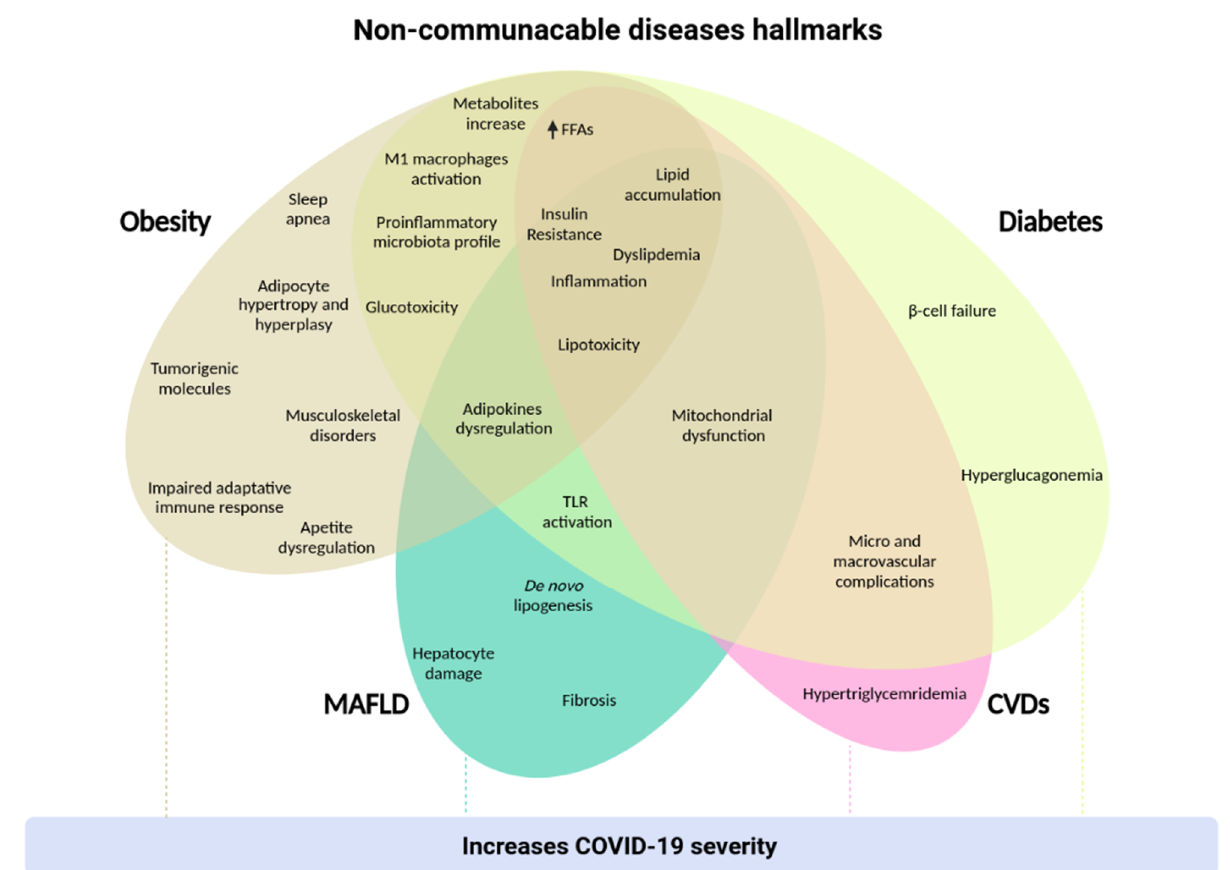
Figure 1. Hallmarks of non-communicable diseases. Scheme with the main characteristics and complications of the NCDs represented in 5-way Veen diagram and their relationship with COVID-19. Obesity is shown in the brown, metabolic associated fatty liver disease—MAFLD—in the blue, cardiovascular diseases—CVDs—in the pink, and diabetes mellitus in the yellow. The relationship between the diseases are shown in the